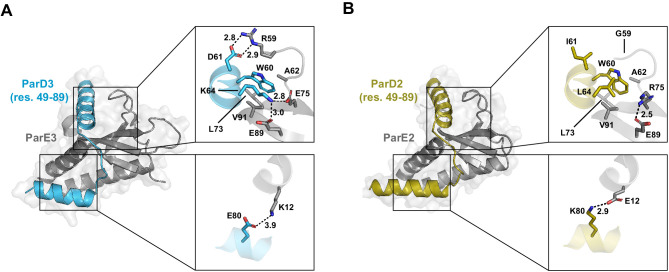
Comparing the interfaces of paralogous toxin-antitoxin complexes.(A) The interface between ParD3 and ParE3 (PDB: 5CEG). Top inset, library positions 1 and 2, with neighboring residues. Bottom inset, library position 3. Salt bridges are indicated by dashed lines. (B) Same as in (A), illustrating the corresponding regions of ParD2-ParE2 (PDB: 6X0A).